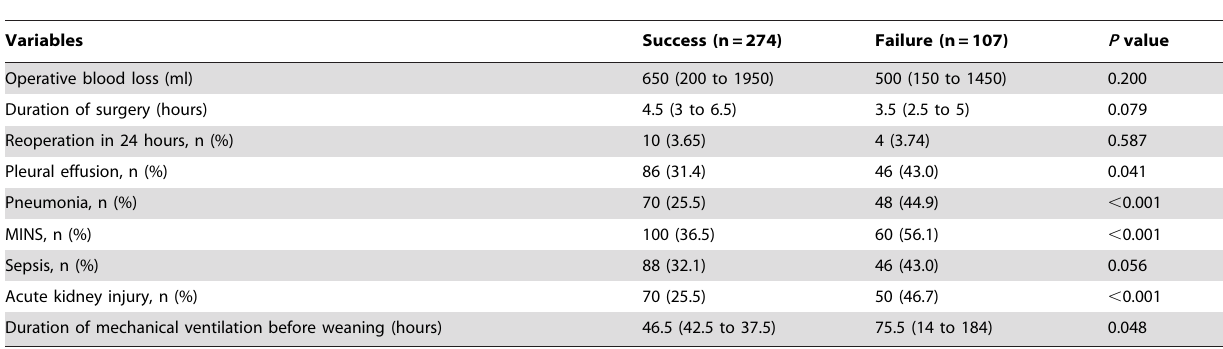
Table 3. Intraoperative and Postoperative Variables.